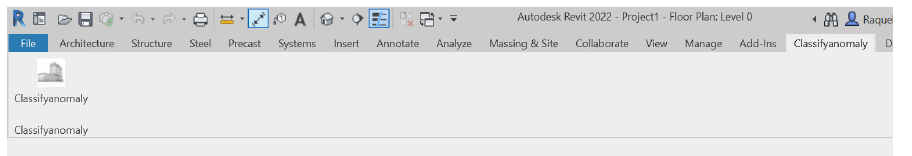
Figure 7. Example of anomaly classification by means of DL model: coverage detachment.